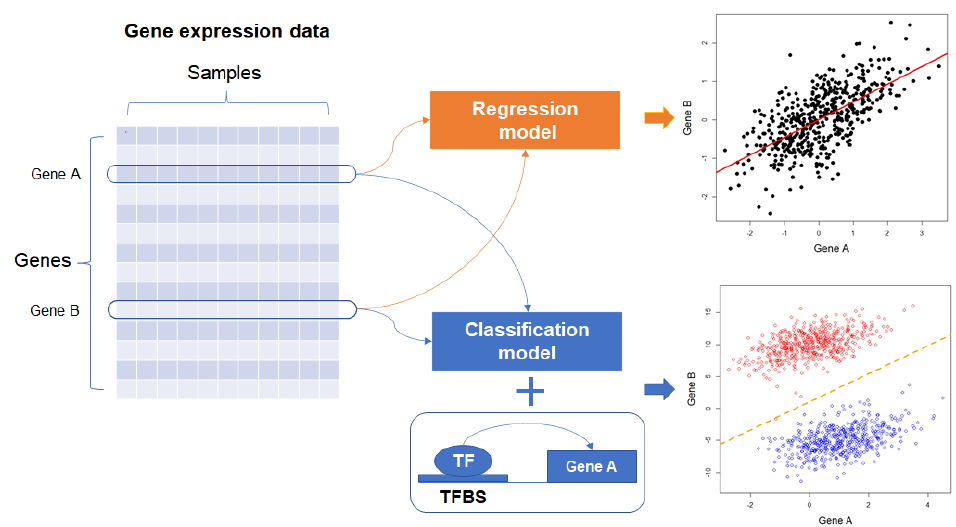
Figure 3. Inference of GRN with supervised learning model. Expression profiles of genes A and B are used for the inference of regulatory relationships. The upper scatter plot indicates regression line between gene A and gene B, and the lower one shows the decision margin (orange-colored dotted line) for discriminating regulatory relationship between gene A and B, which is estimated with the expression profiles of the genes and prior biological knowledge such as TF and TFBS. TF: transcription factor; TFBS: TF binding site.